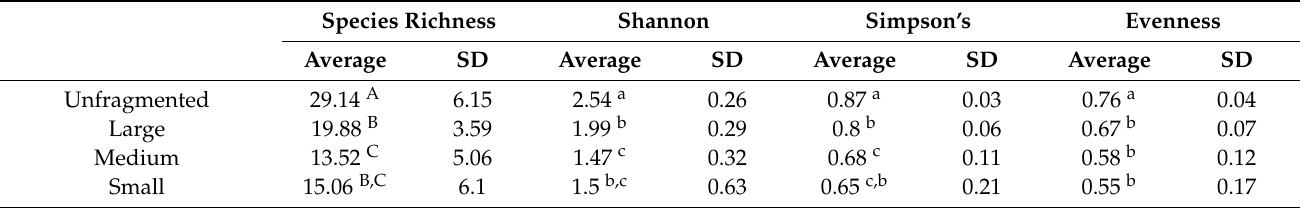
Table 4. Diversity indices in an unfragmented forest, large, medium, and small forest fragments. Different uppercase and lowercase letters represent significant differences at p < 0.05 for Tukey HSD or Mann–Whitney pairwise test,